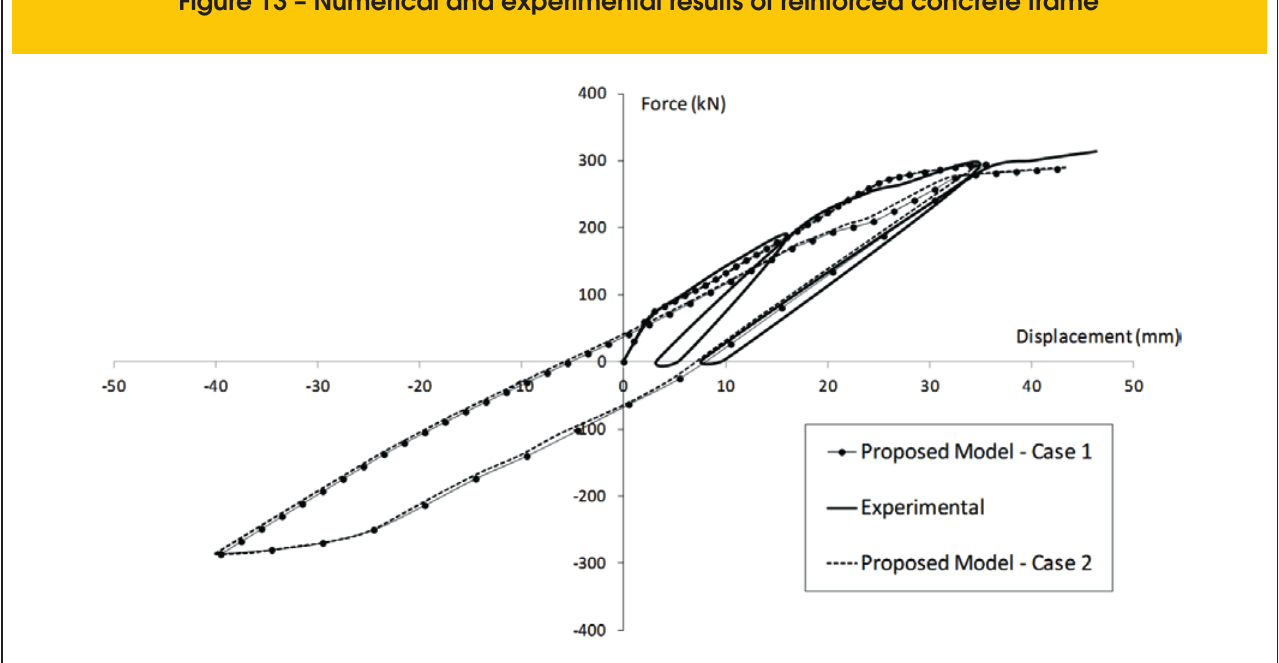
Figure 13 – Numerical and experimental results of reinforced concrete